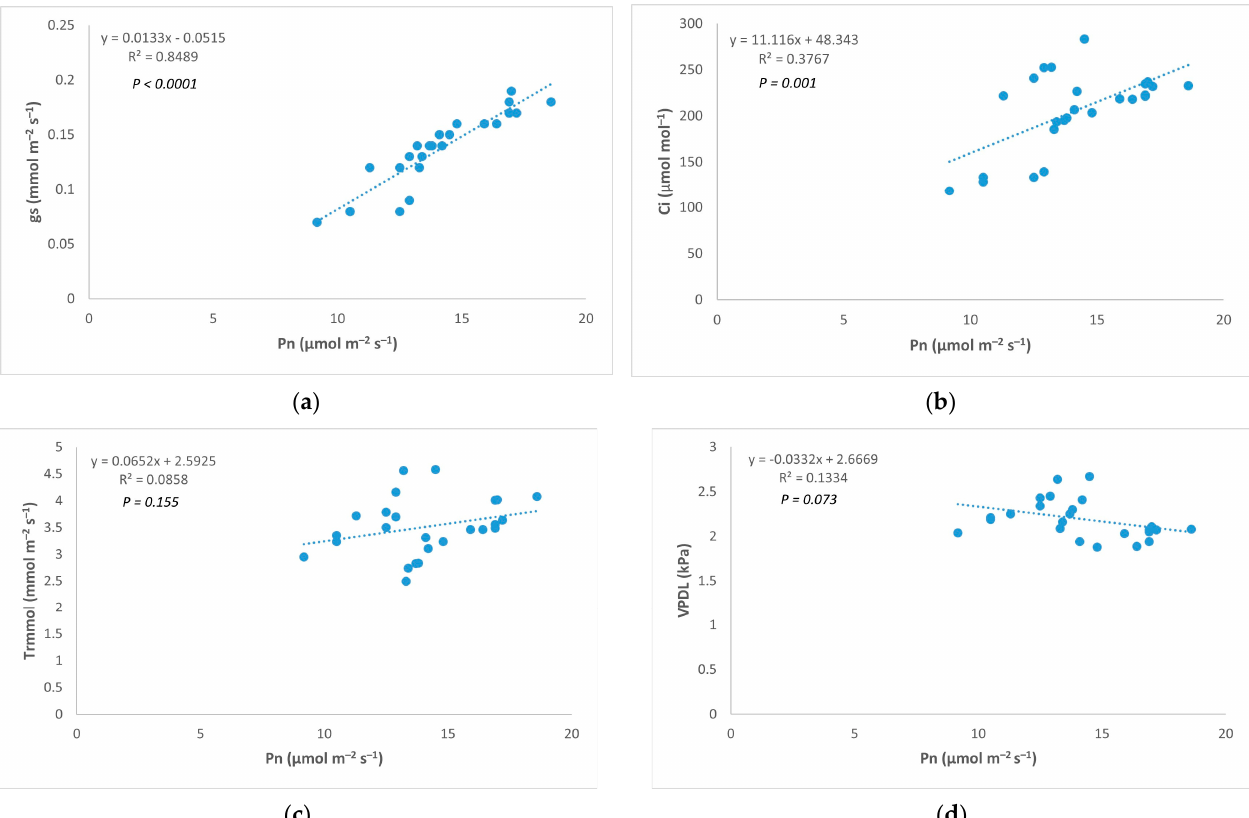
Figure 1. Correlation of photosynthesis. ( a ) Correlation between net photosynthesis (Pn) and stomatal conductance ( g s ); ( b ) Correlation between net photosynthesis (Pn) and intracellular CO 2 concentration (Ci); ( c ) Correlation between net photosynthesis (Pn) and leaf transpiration rates (Trmmol); ( d ) Correlation between net photosynthesis (Pn) and leaf-to-air vapor pressure deficit (VPDL).